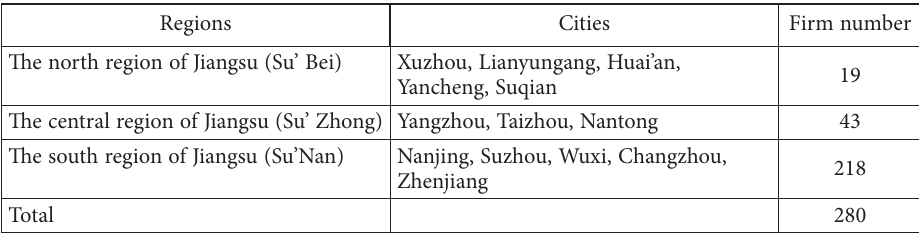
Table A.6. Area distributions based on the PSM